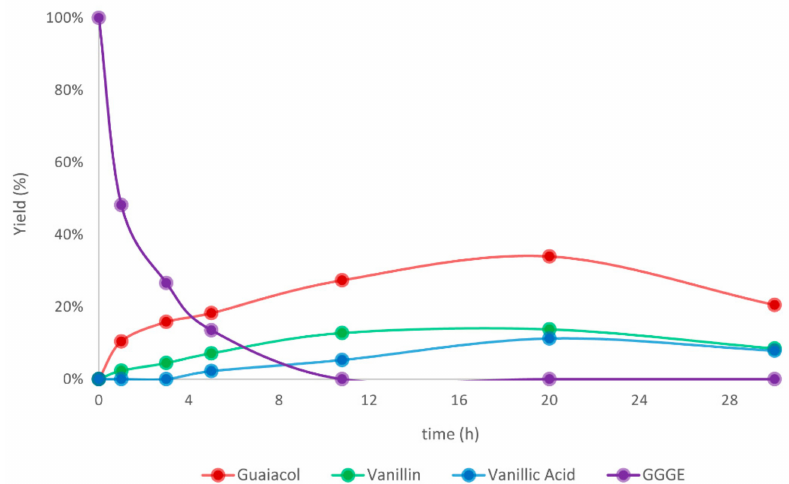
Figure 4. Time-course study for the GGGE oxidation with 5 wt.% Ru / Al 2 O 3 (3) catalyst. Reaction conditions: 10 mL 0.017 M GGGE in acetonitrile, 40 mg catalyst, 160 ◦ C, 5 bar (20% oxygen in